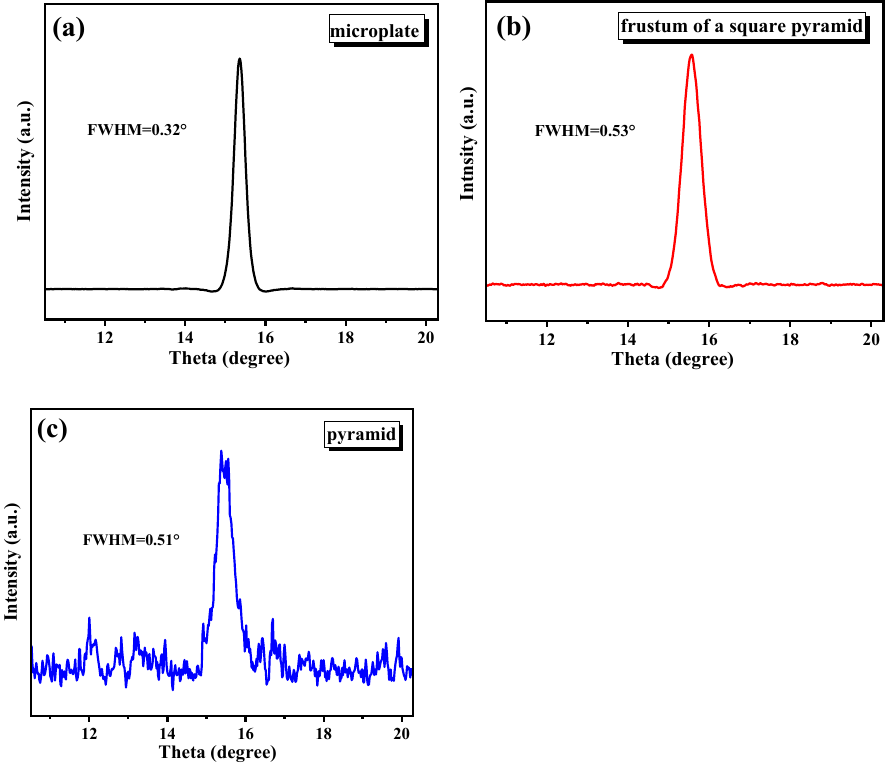
Figure 7. Rocking curve of the CsPbBr 3 microplate ( a ), frustum of a square pyramid, ( b ) and pyramid ( c